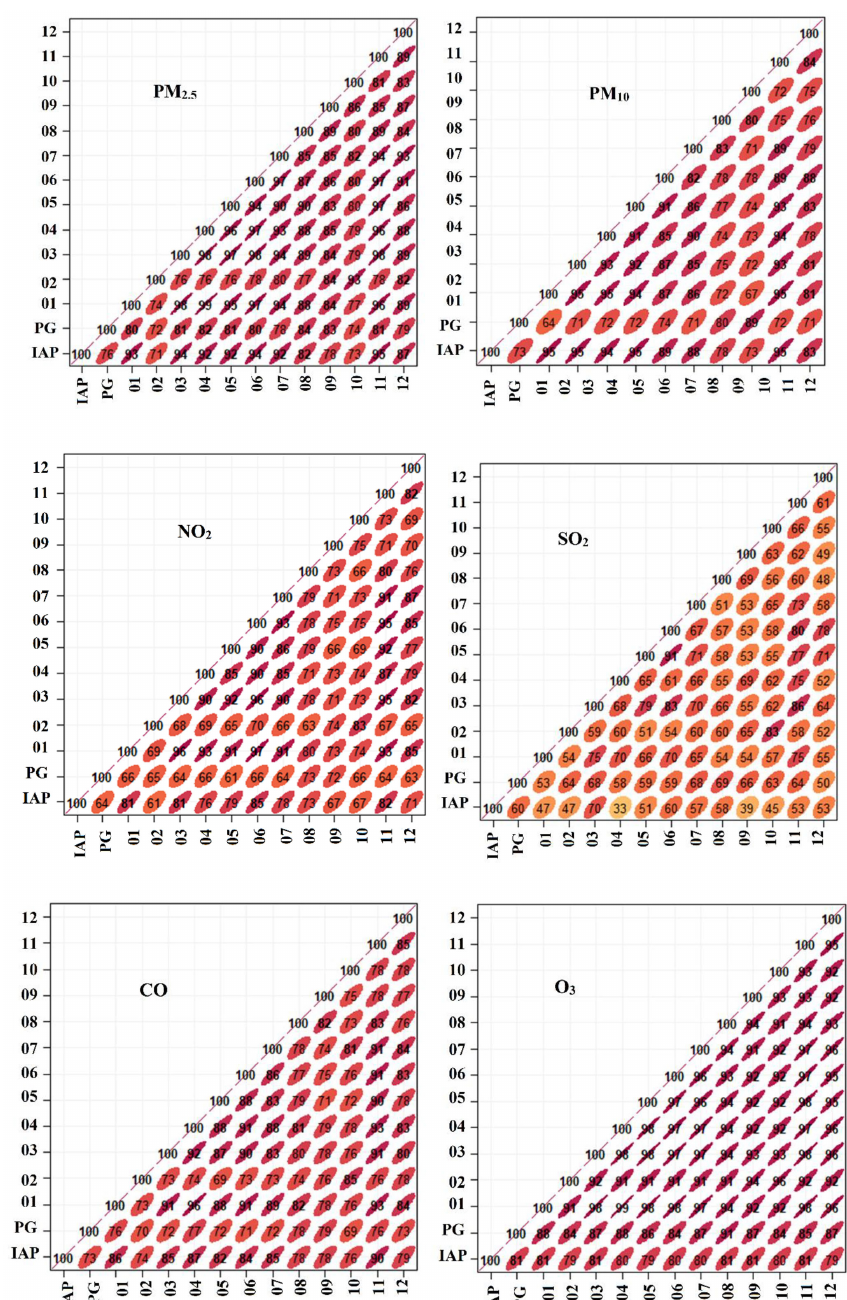
Figure 9. Correlations between the air quality at IAP, PQ and 12 monitoring station around Beijing. Stations G1–G12 (Fig. 1b) are labelled 01–12; PG is